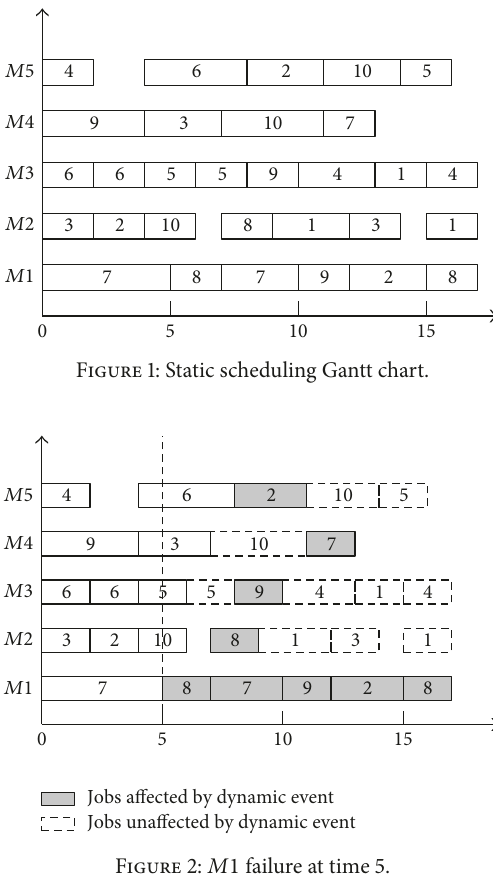
Figure 2: 𝑀1 failure at time 5.